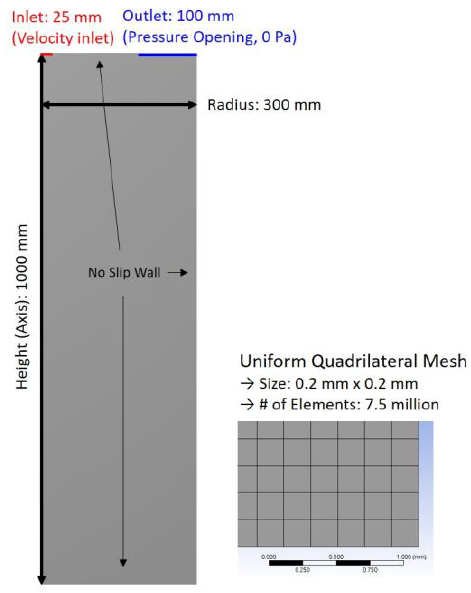
Figure 2. Domain and mesh information for two-dimensional simulation of melt jet breakup.